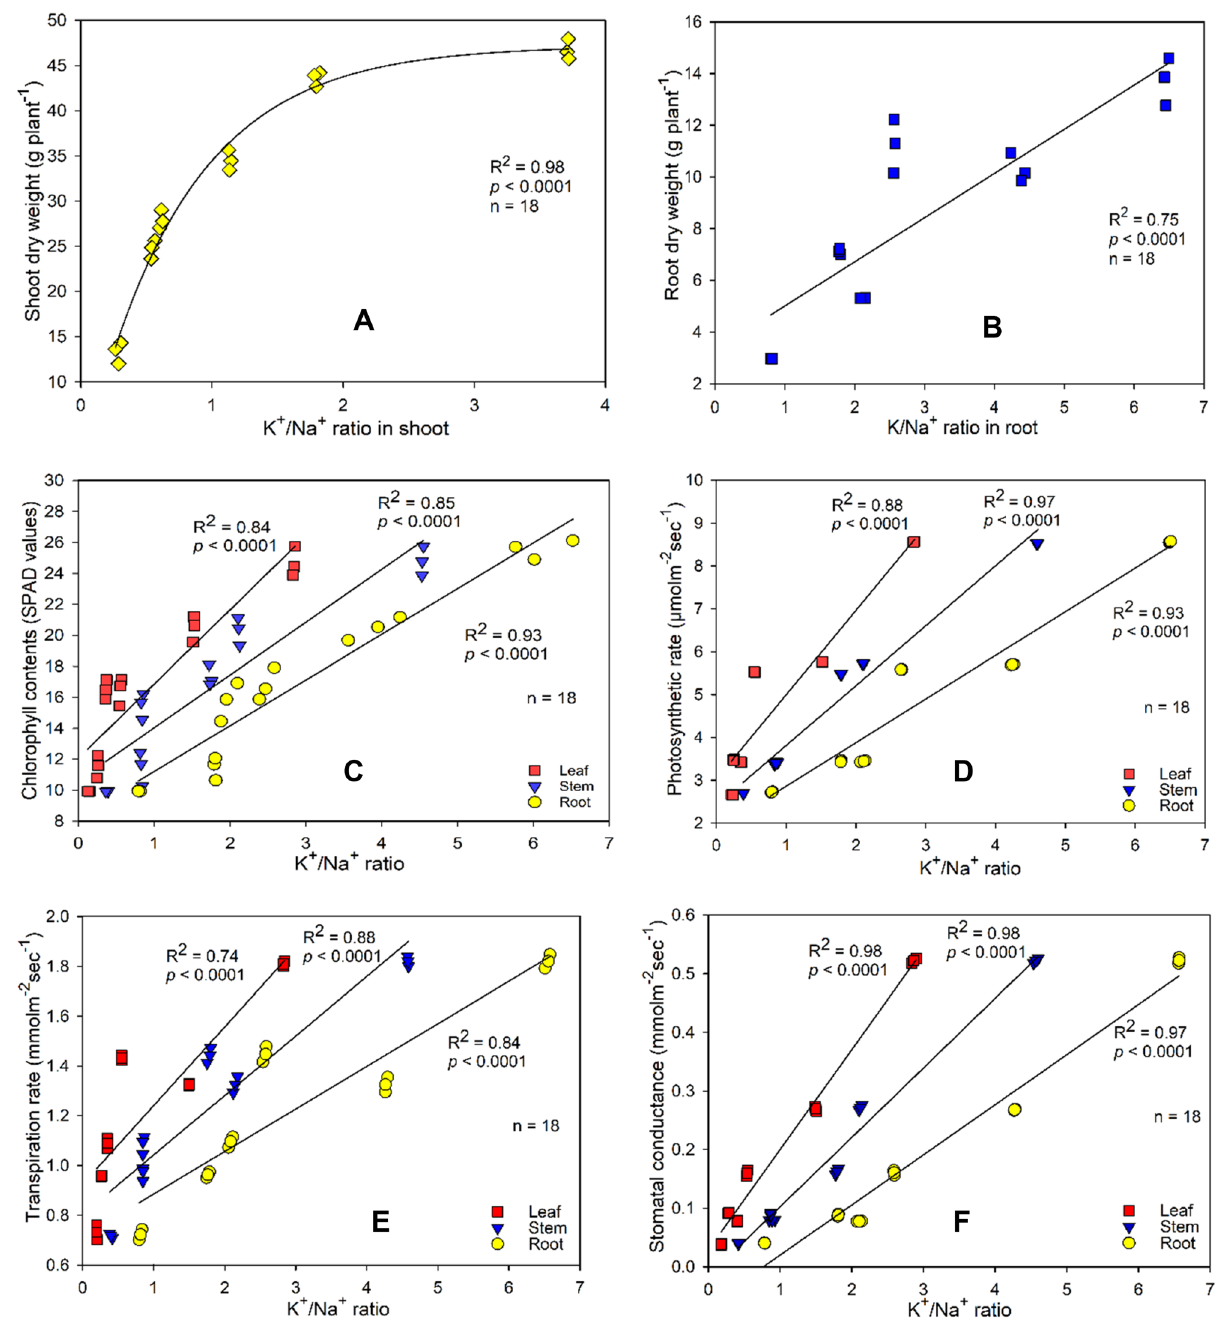
Figure 5. Relationship between K + /Na + ratio and ( A ) Shoot dry weight and ( B ) Root dry weight, and physiological attributes ( C ) Chlorophyll content ( D ) Photosynthetic rate ( E ) Transpiration rate and ( F ) Stomatal conductance. The coefficient of regression is denoted by “R 2 ” and “ p” represents the level of